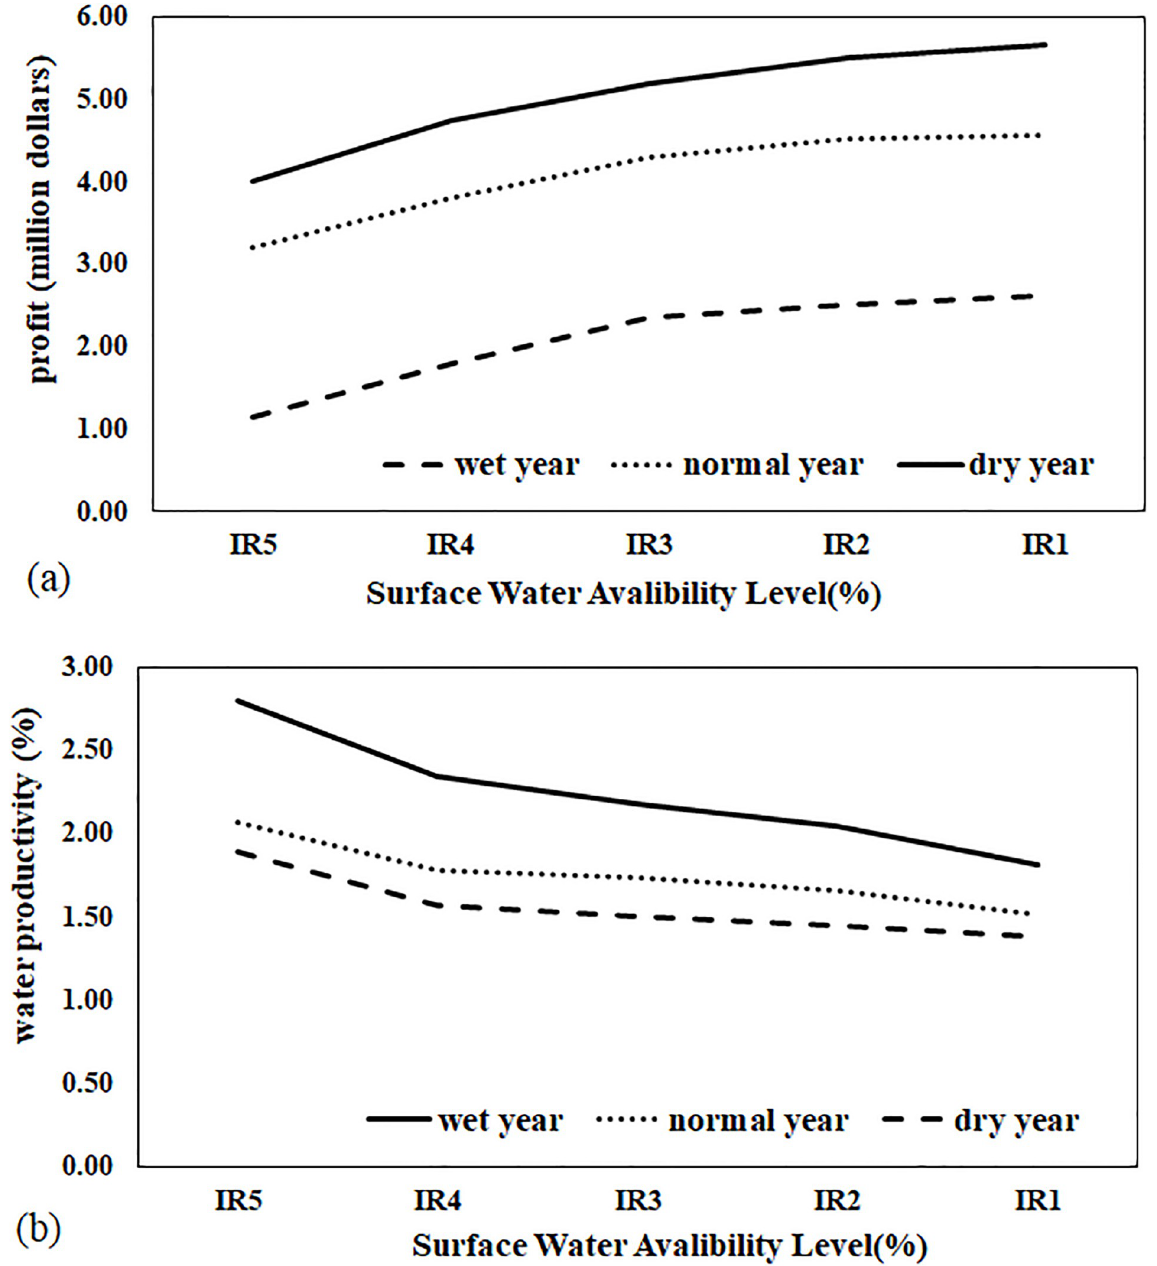
Fig 8. (a) profits and (b) water productivity in wet, normal and dry